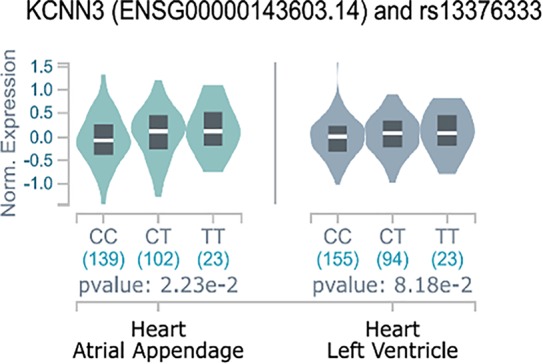
eQTL effects of rs13376333 on KCNN3. Y-axis indicates normalized expression value of KCNN3 according to the GTEx standard analysis pipeline (Carithers et al., 2015). The figure shows that the expression of KCNN3 in atrial appendage is increased in the 23 GTEx individuals with the rs13376333-T/T genotype, as compared to both the 102 heterozygote (C/T) GTEx individuals and the 139 individuals that are major allele homozygote (C/C). Having the T-allele have also been shown to increase risk of AF (Ellinor et al., 2010; Ellinor et al., 2012; Christophersen et al., 2017). These findings were replicated in an independent eQTL data (P = 0.0162, n = 127).